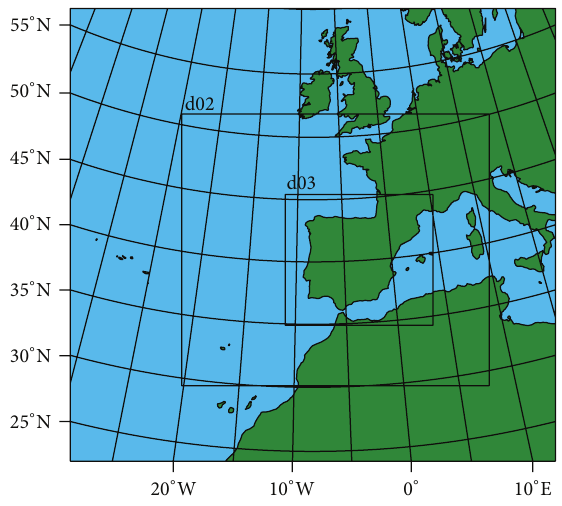
Figure 1: WRF model domains used for the